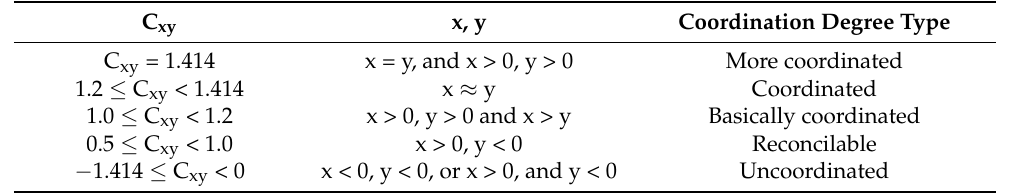
Table 2. The Type of Coordination Degree.